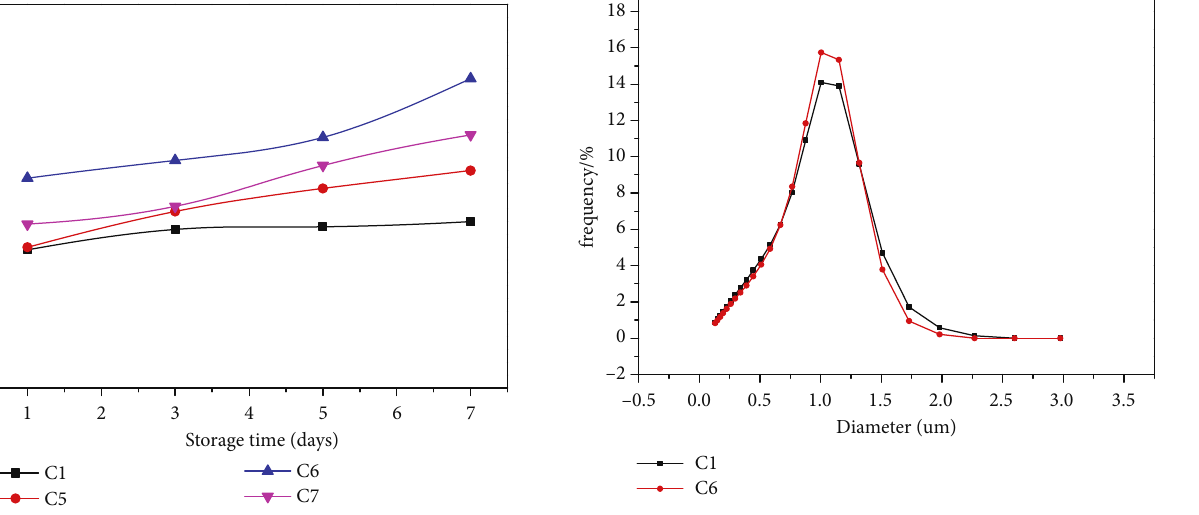
Figure 5: Particle size distributions of CNRL rubber